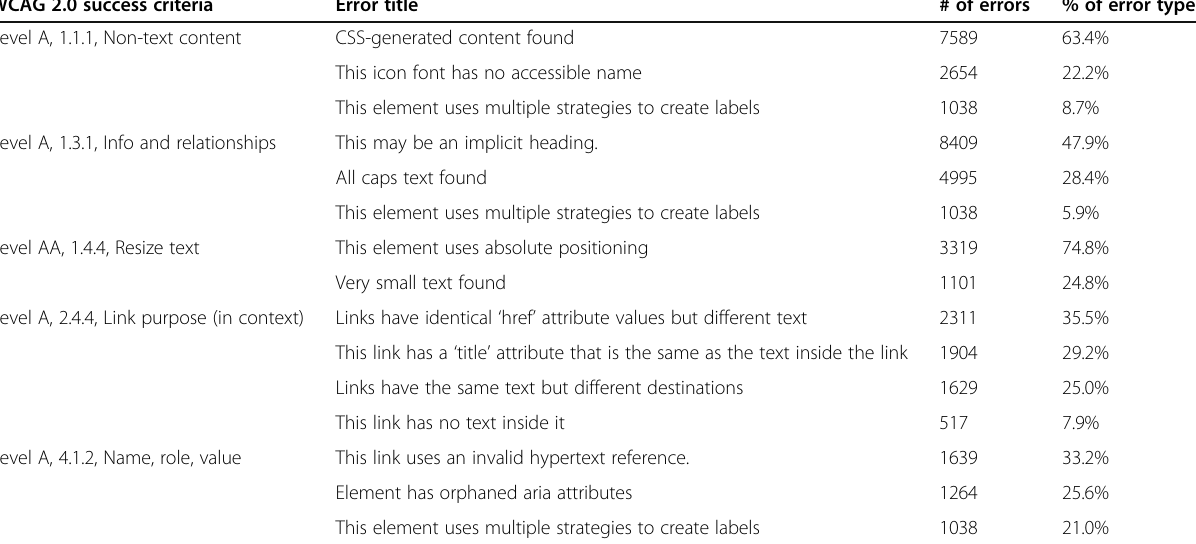
Table 6 Most common error titles identified by Tenon aligned with the most common WCAG errors for this sample. Only error titles that comprised at least 5% of the errors within a particular WCAG success criteria are presented